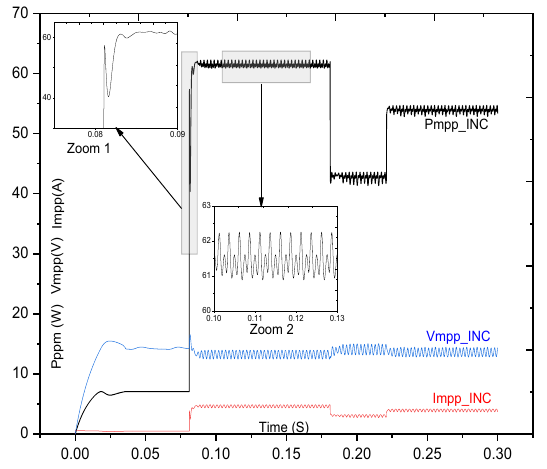
Figure 7: Response in terms of PV module power with the "INC_C" algorithm